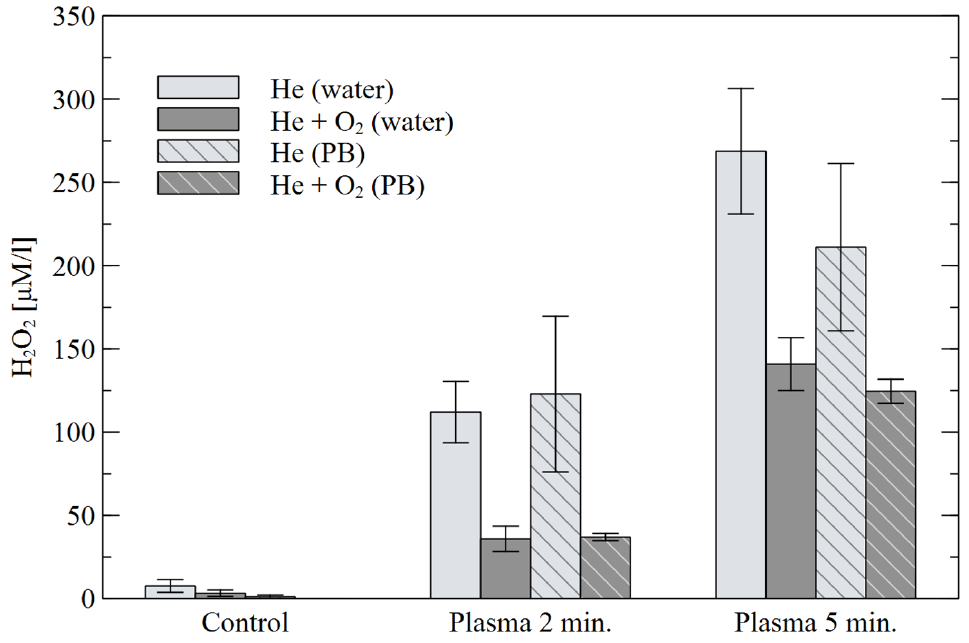
Figure 8. Concentration of H 2 O 2 in water and PB for different plasma treatment times.